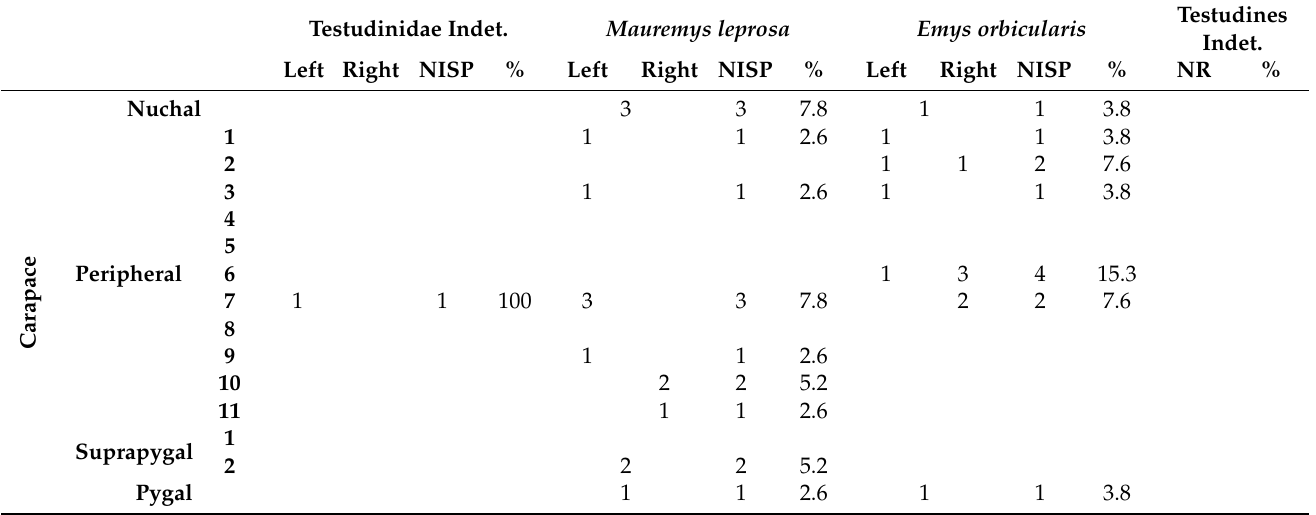
Figure 2. MG 8217.1/MG 8217.2 Carapacial turtle plates selection from the Middle Palaeolithic site of Mealhada (Coimbra, central Portugal) in dorsal ( left ) and ventral ( right ) views. Mauremys leprosa plates selection ( A , D , F , H ): ( A ), nuchal; ( D ), left 3 peripheral; ( F ), suprapygal 2; ( H ), pygal. Emys orbicularis plates selection ( B , E , G ): ( B ), nuchal; ( E ), left 3 peripheral; ( G ), pygal. ( C ), left 7 peripheral of Testudinidae indet. ( A’–H’ ), plates figuration. Red rectangle indicates a burned area. Table 1. Turtle remains from the Middle Paleolithic site of Mealhada (Coimbra, central Portugal) identified in the Museu Geol ó gico de Lisboa (Lisbon, Portugal). The number of shell skeletal elements identified (and indeterminate) by taxon, NISP and percentage are